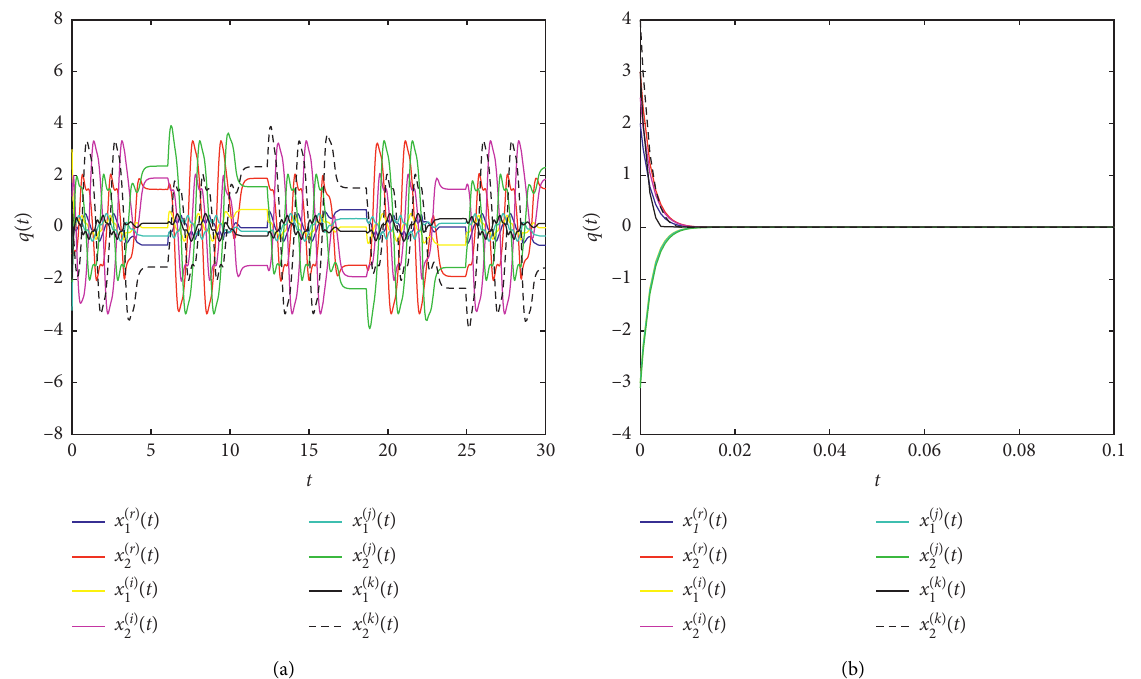
Figure 1: The state trajectories of x r ( t ) , x i ( t ) ,x j ( t ) ,x k ( t ) of QVVNs (29). (a) With I(t) � 0. (b) Under controller (31).